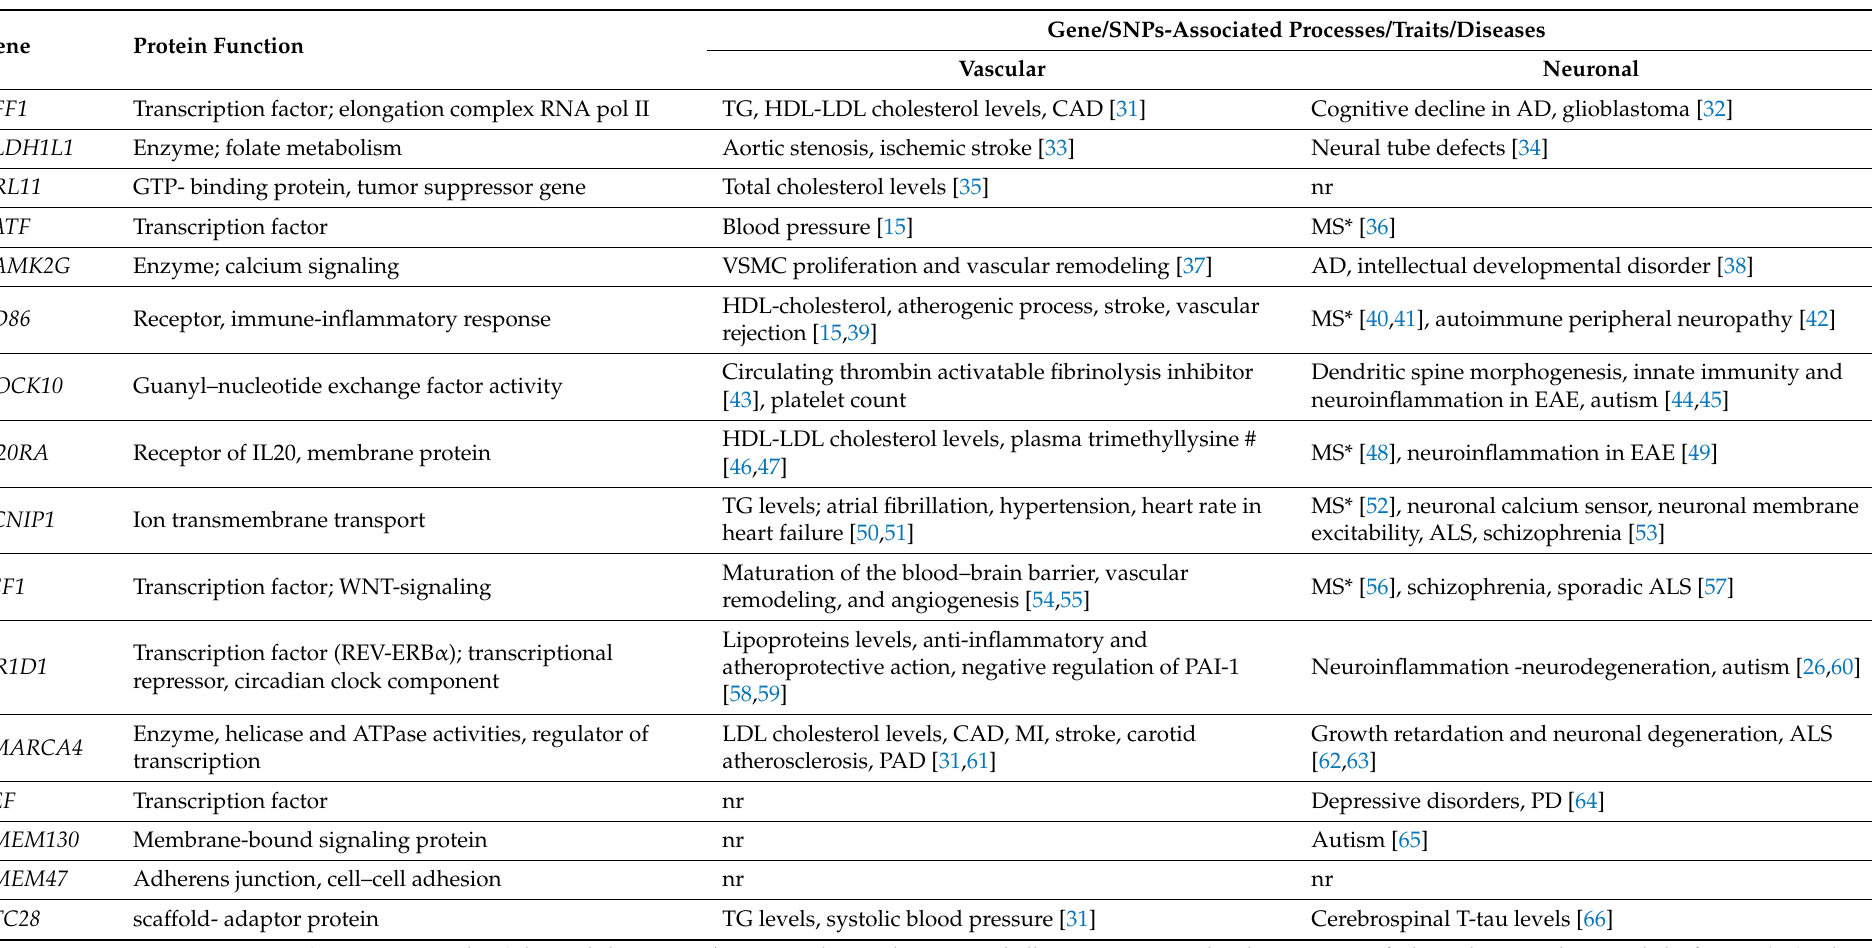
Table 4. MS- GWAS genes differentially expressed between MS and control IJV walls: association with neuro/vascular processes, traits, and